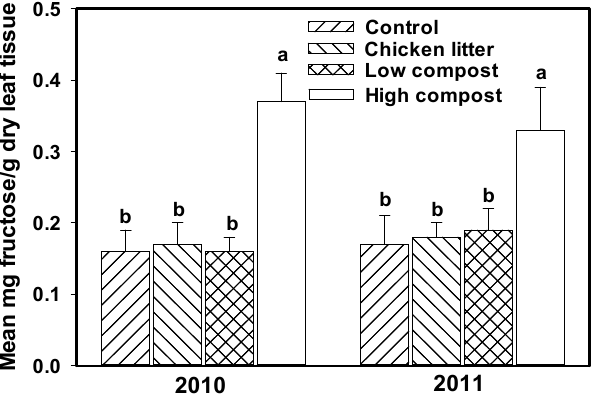
Figure 2. Mean ( SE) mg/g dry weight of fructose found in leaves of sugarcane, maize, and sorghum; different letters over bars within each type of sugar indicate significant differences ( p < 0.05) [93].